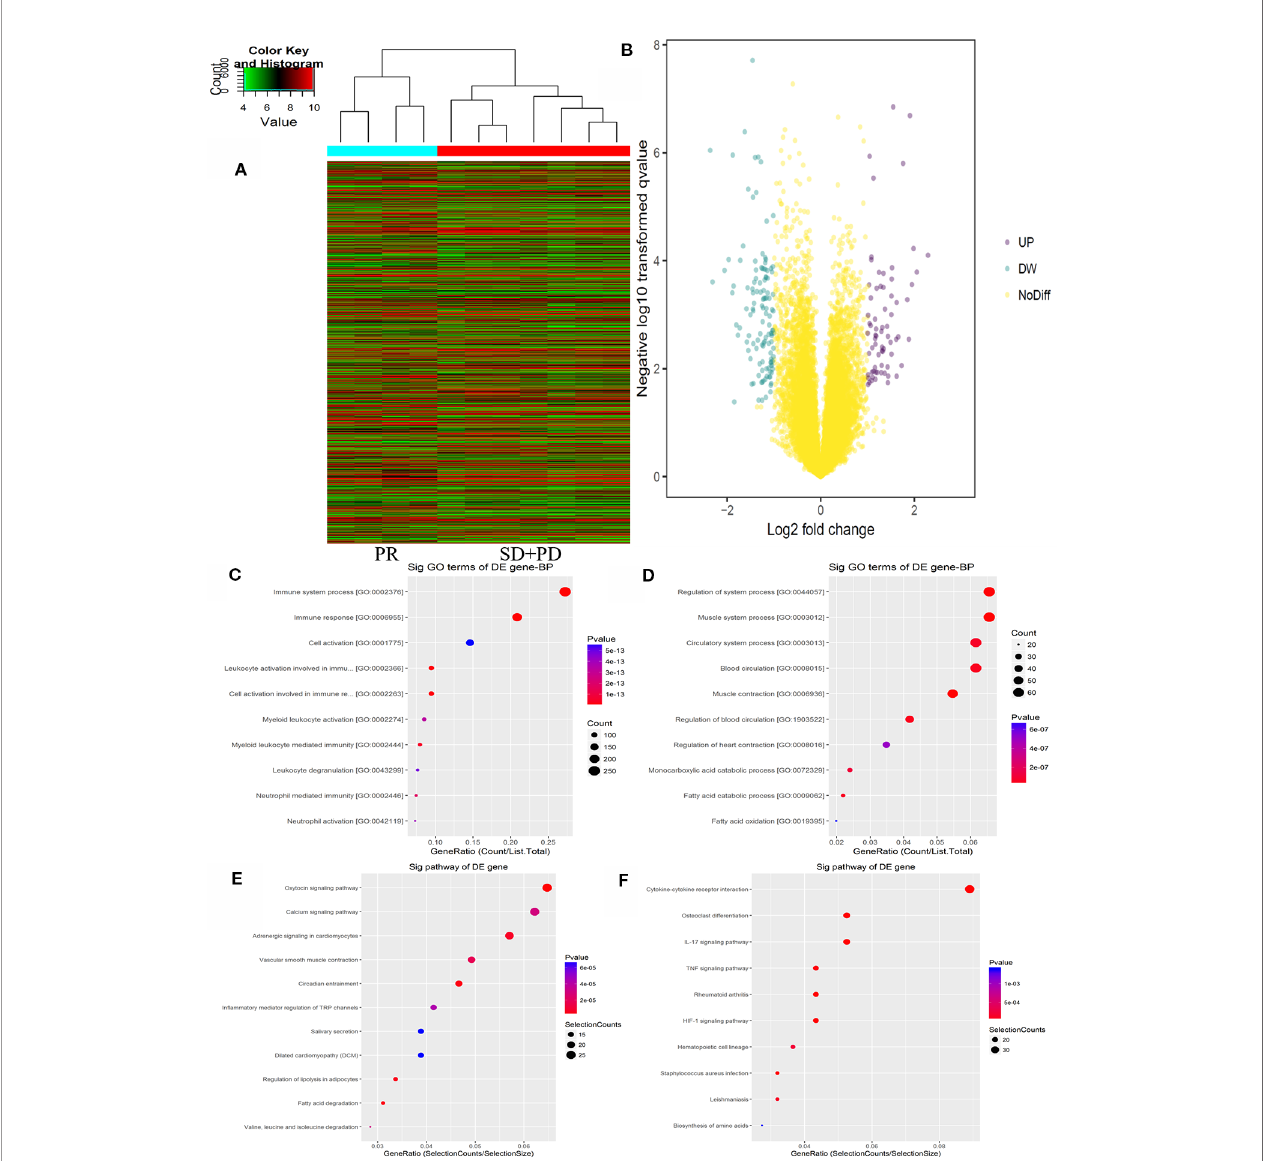
FIGURE 2 | mRNAs expression pro fi le comparison between chemotherapy-resistance and chemotherapy-sensitivity groups. Gene Ontology (GO) functional and Kyoto Encyclopedia of Genes and Genomes (KEGG) pathway analysis of the differentially expressed genes. (A) The hierarchical clustering of all targets value of mRNA expression pro fi ling among samples. (B) between the chemotherapy-resistance and chemotherapy-sensitivity group. The purple dots indicated the up- regulated genes of mRNAs and the green dots indicated the down-regulated genes of mRNAs. (C) GO functional analysis of the top ten functional classi fi cations of the upregulated genes. (D) GO functional analysis of the top ten functional classi fi cations of the downregulated genes. (E) KEGG pathway analysis of the top ten signi fi cant pathways of upregulated genes. (F) KEGG pathway analysis of the top 10 pathways of downregulated